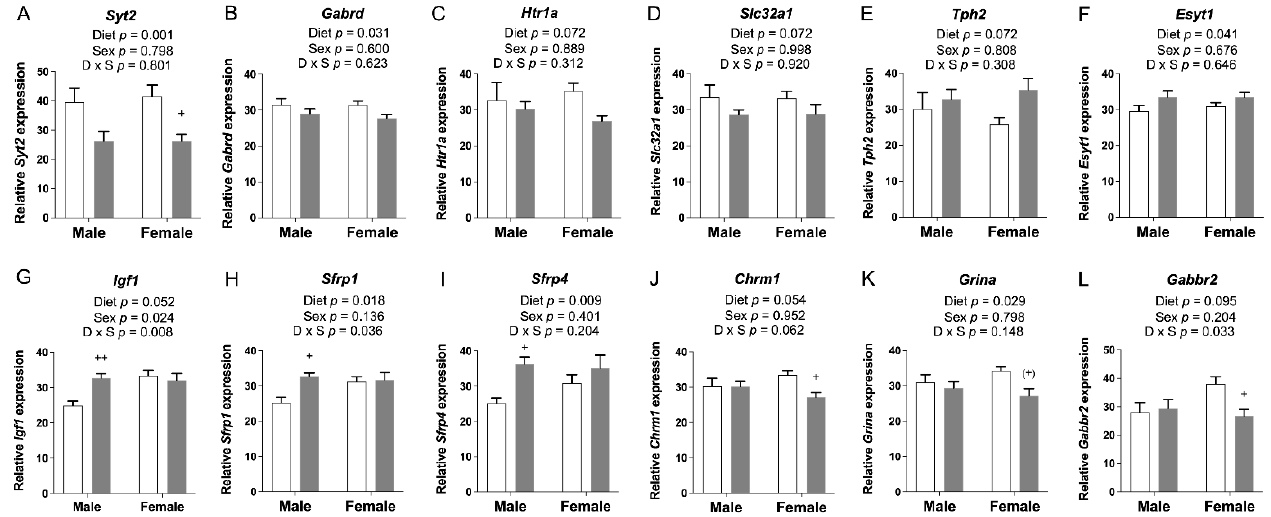
Figure 2. qRT-PCR assessment of candidate gene expression in P30 pup cortices. ( A ) mRNA levels of Syt2 and ( B ) Gabrd were significantly decreased in FASD pups. ( C ) mRNA levels of Htr1a and ( D ) Slc32a1 showed a trend toward a significant decrease in FASD pups. ( E ) mRNA levels of Tph2 showed a trend toward a significant increase in FASD pups. ( F ) mRNA levels of Esyt1 were significantly increased in FASD pups. ( G ) mRNA levels of Igf1 were significantly increased in FASD male pups, and in females compared with males. ( H ) mRNA levels of Sfrp1 and ( I ) Sfrp4 were significantly increased in FASD male pups. ( J ) mRNA levels of Chrm1 were significantly decreased in FASD female pups. ( K ) mRNA levels of Grina were significantly decreased in FASD pups, although mainly in females. ( L ) mRNA levels of Gabbr2 were significantly decreased in FASD female pups. White bars: CD; gray bars: FASD. Values are means ± SEM of 6–8 per group. p -Values from 2-factor ANOVA are indicated at the top of each graph, and Tukey post hoc p -values are indicated as + p < 0.05, ++ p < 0.01, and (+) p = 0.056. CD: control diet; FASD: folic-acid-supplemented diet; D: diet; S: sex; D × S: diet × sex